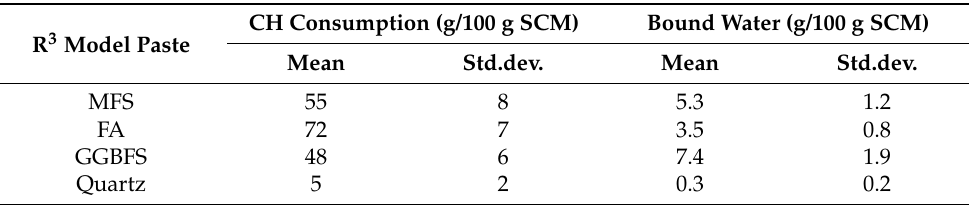
Table 6. Reactivity assessment of R 3 model paste—CH consumption calculated from ThermoGravi- metric Analysis (TGA) analysis and Bound water calculated by oven method. CH Consumption (g/100 g SCM) Bound Water (g/100 g SCM) R 3 Model Paste Mean Std.dev. Mean Std.dev. MFS 55